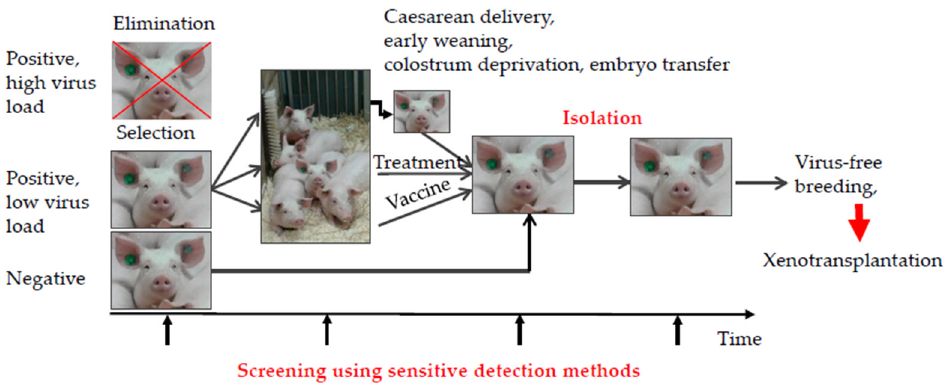
Figure 2. Elimination programs of potentially zoonotic pig viruses.